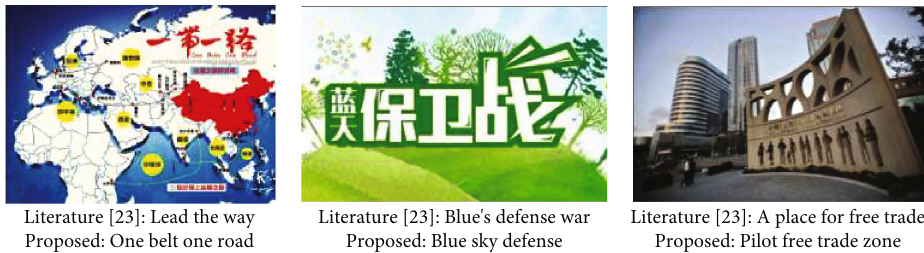
Figure 8: Comparison of recognizing multimedia image information between the proposed model and the model in literature [23].